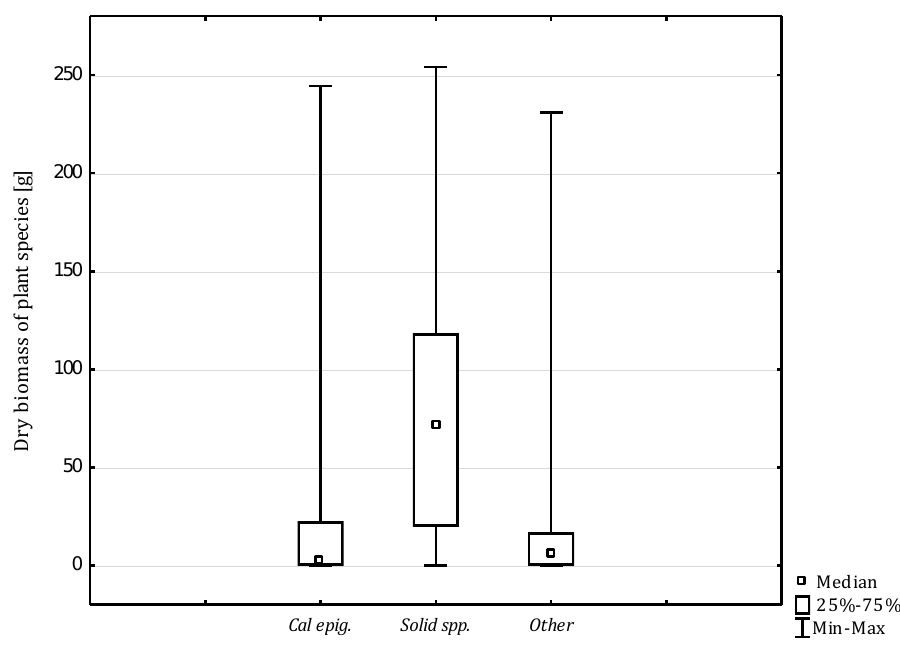
Median 25%-75% Min-Max Cal epig. Solid Fig. 3. Average biomass of species after drying (author’s own research) Table 2. Relationship between percentage occurrence of the species (author’s own research) (Spearman rank test, *statistically significant results p< 0,05) Mean of fresh Standard Calamagrostis Solidago spp . Other species biomass [g] deviation (SD) epigejos Calamagrostis epigejos 40.92 77.43 1.00 -0.52* -0.09 Solidago spp. 102.04 84.58 -